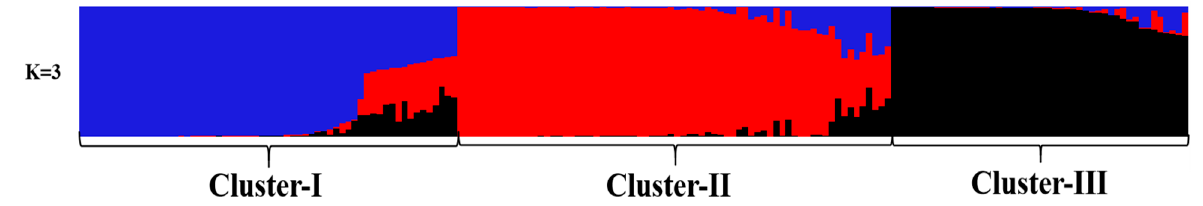
Figure 6. Diagnostic plots of delta ‐ K from the STRUCTURE analysis of the 179 D. kaki germplasms populations.